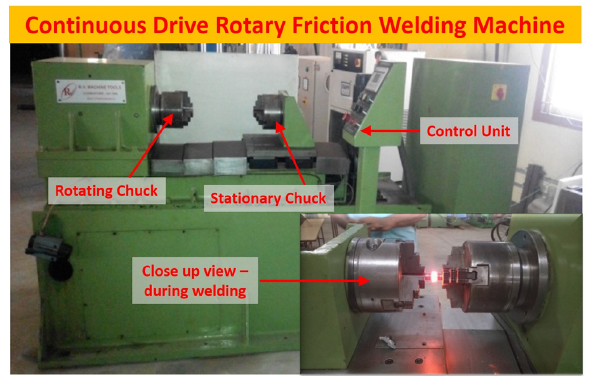
Figure 1: Photograph of RFW